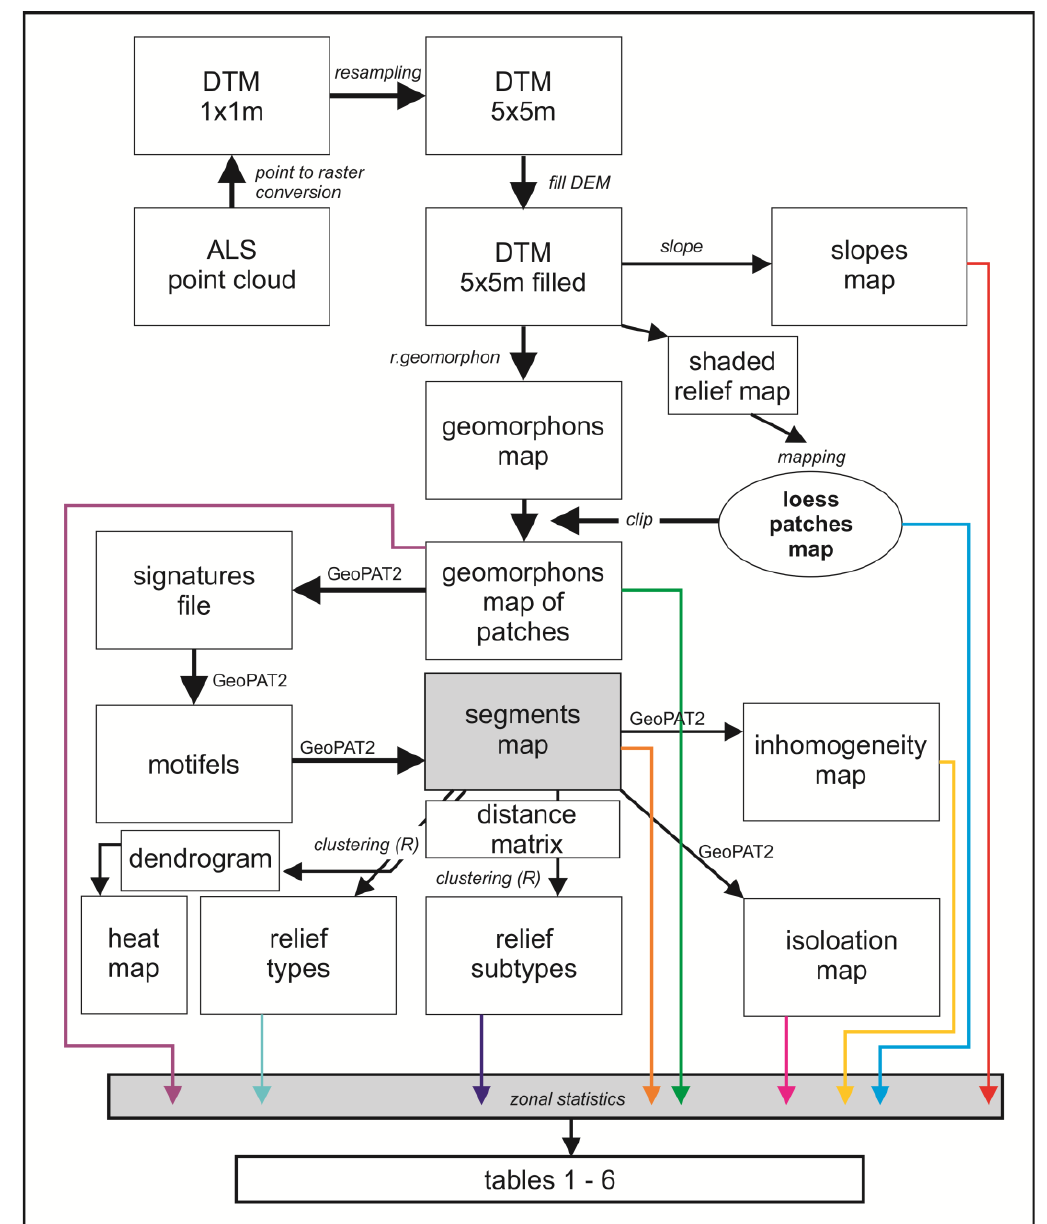
Figure 2. Flowchart of data processing and calculations.